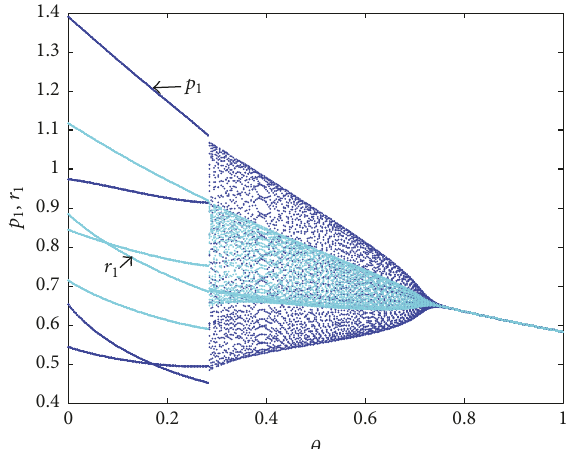
Figure 14: The bifurcation diagram of 𝑝 1 and 𝑟 1 with respect to 𝜃 when 𝛼 = 0.5 , 𝑤 𝑖 = 0.5 , and 𝛼 1 = 𝛼 2 = 0.25